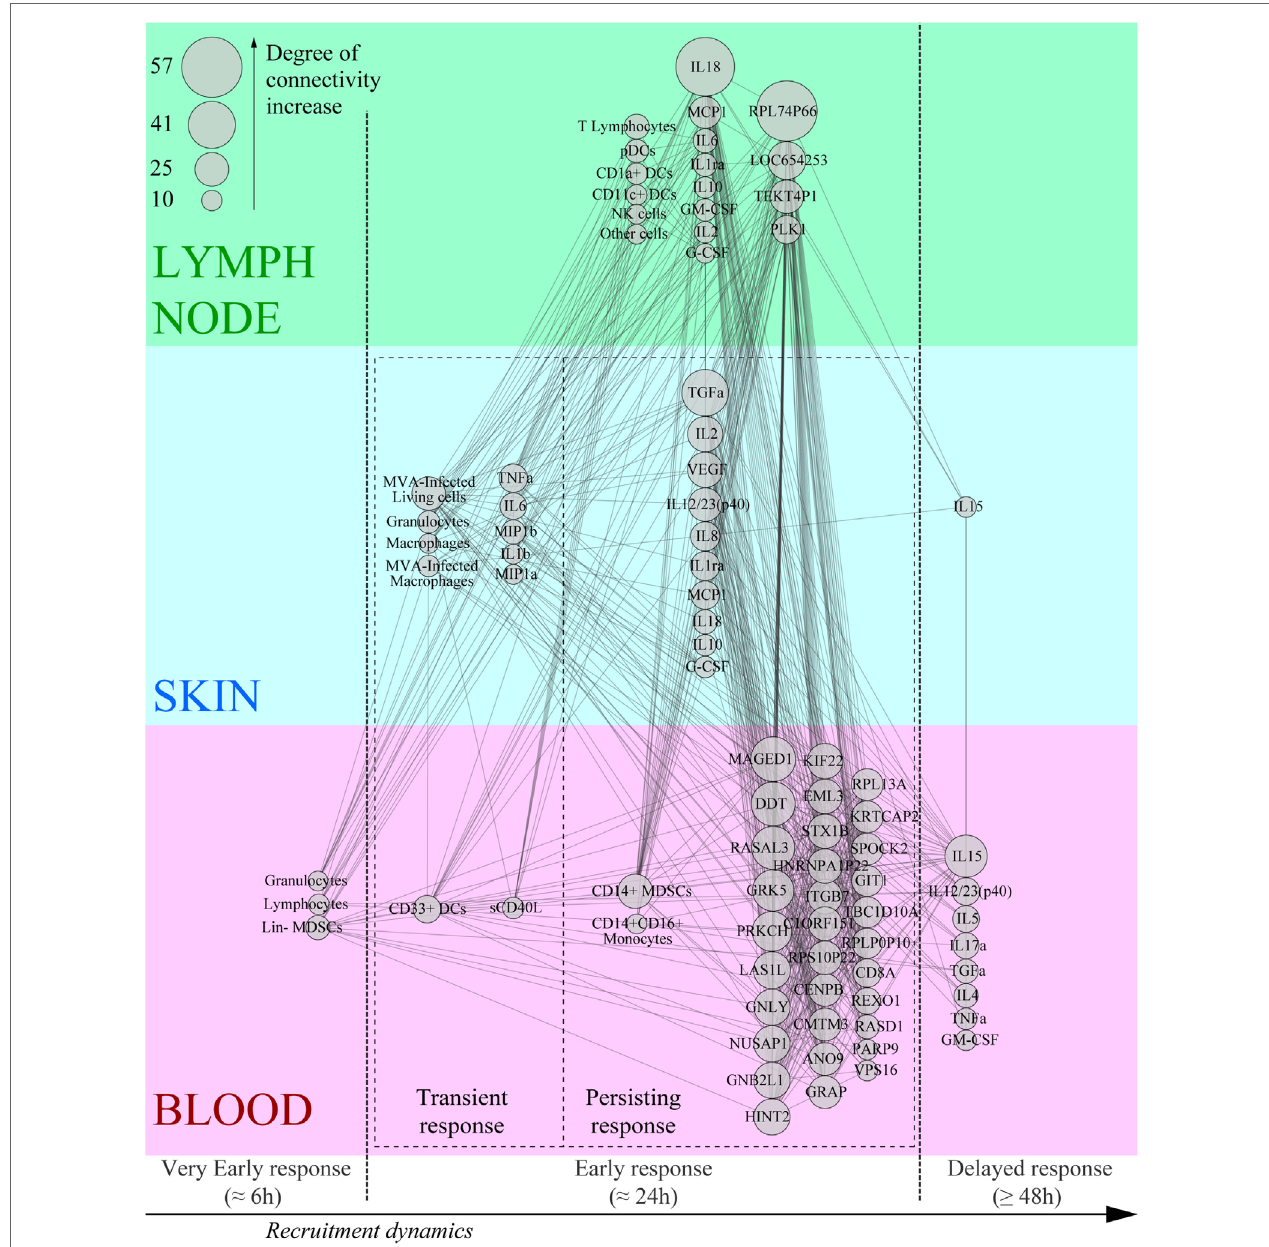
FigUre 7 | Co-expression network based on the kinetics of recruitment of key effectors of the Modified virus Ankara-induced innate response. The most highly correlated variables (degree of connectivity > 10) were sorted according to their compartment, their type, and their kinetics of expression after rMVA